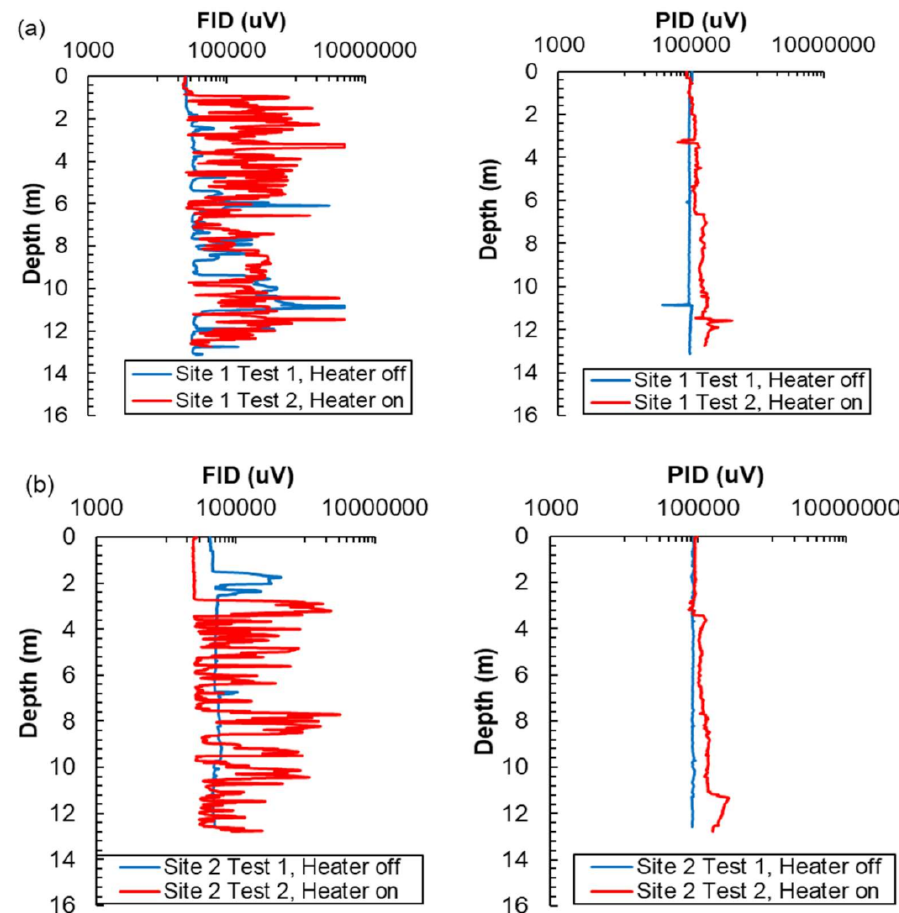
Figure 4. FID and PID responses for the MIP test at Sarpy County landfills: ( a ) Site 1 and ( b ) site